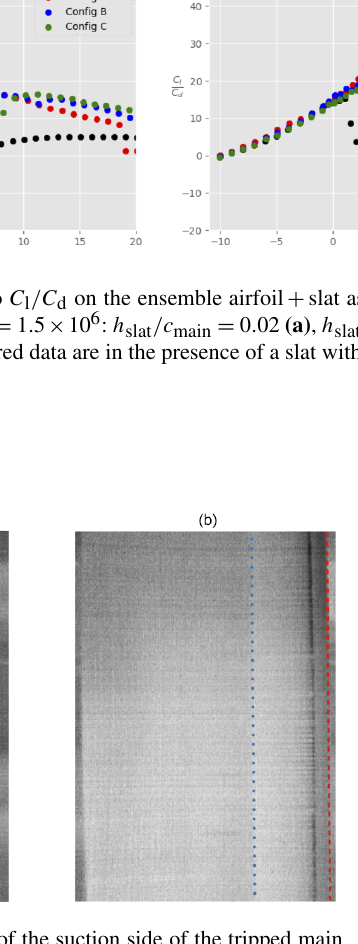
Figure 15. Infrared images of the suction side of the tripped main airfoil at an angle of attack α = 10 ◦ : without slat (a) and with slat under configuration A (b) . In panel (b) , the red dashed line indi- cates the slat leading edge, whilst the blue dotted line shows the slat trailing